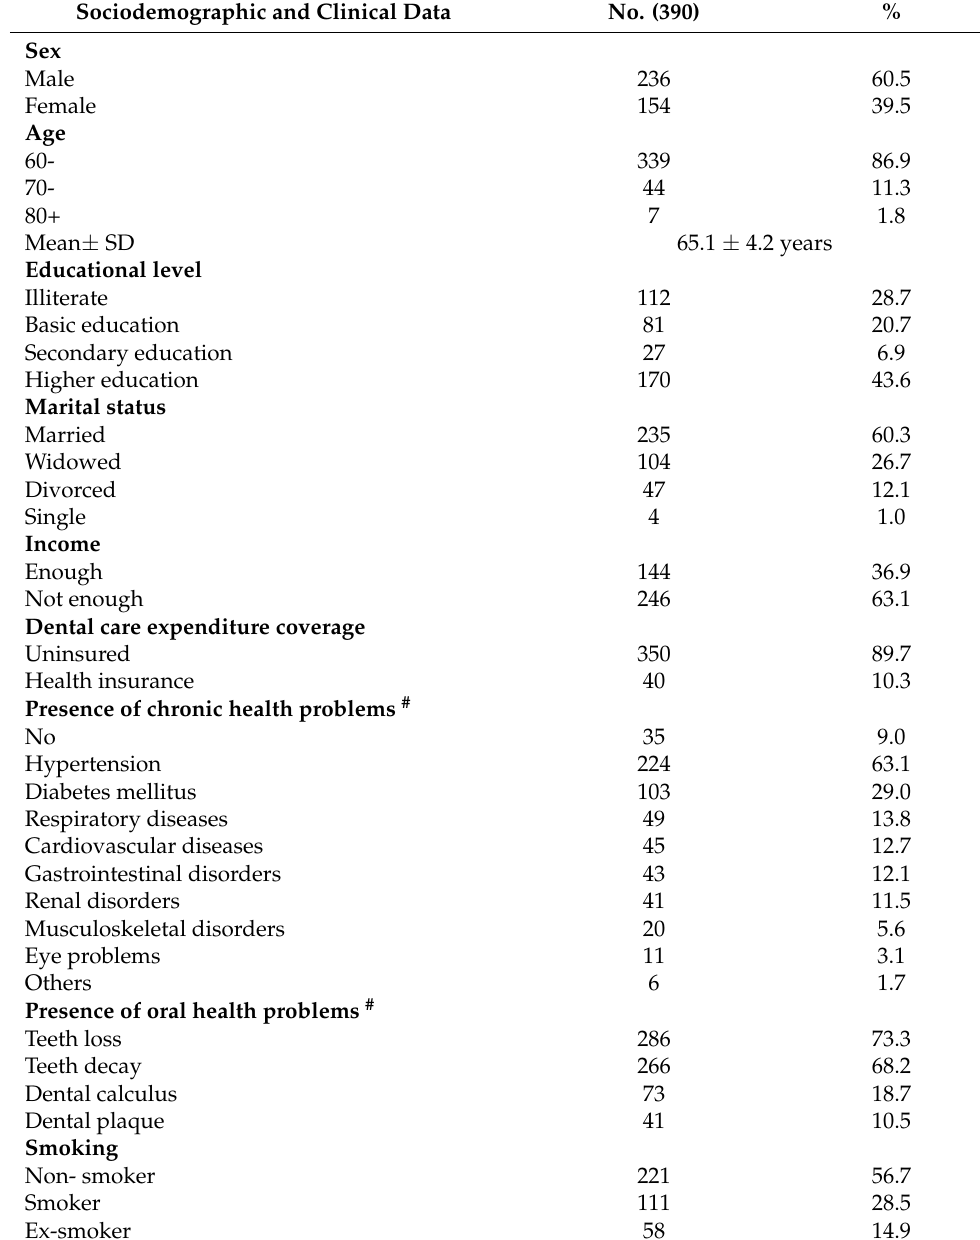
Table 1. Older adults’ sociodemographic and clinical data.